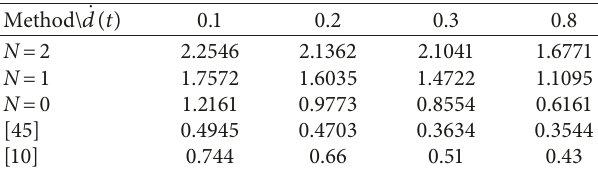
Figure 4: The release instants and release intervals of the ETS with constant parameter σ . Table 2: The value of τ M corresponding to different _ τ ( t )( d � − d � _ d ( t )) 2 1